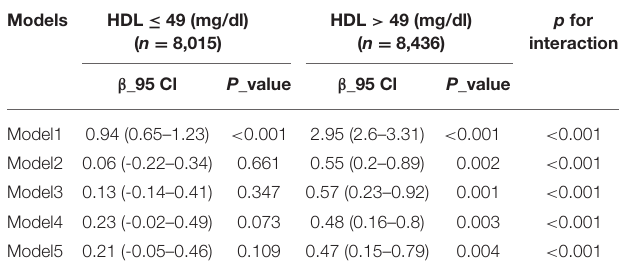
Model1: not adjusted. Model2: adjusted for age, gender, and race. Model3: model2 + marry status, BMI, PIR, and education level. Model4: model3 + DM, Hypertension, smoking status, work activity, alcohol consumption, and CVD. Model5: model4 +